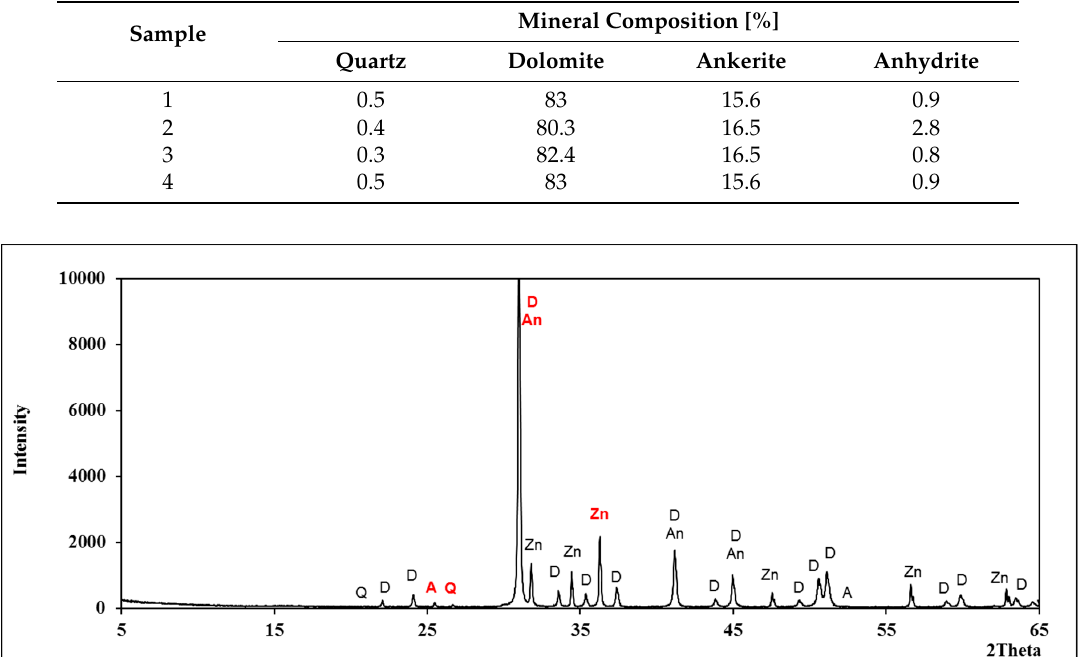
Table 4. Properties of composite cores. Figure 2. ( a ) Opened core plug with spacers; ( b ) and ( c ) assembled core plug with a centrally placed fracture supported by spacers.